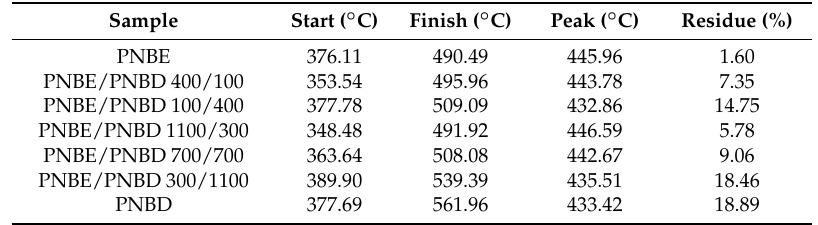
Table 2. TGA results (main decomposition peak) at the heating rate of 10 ◦